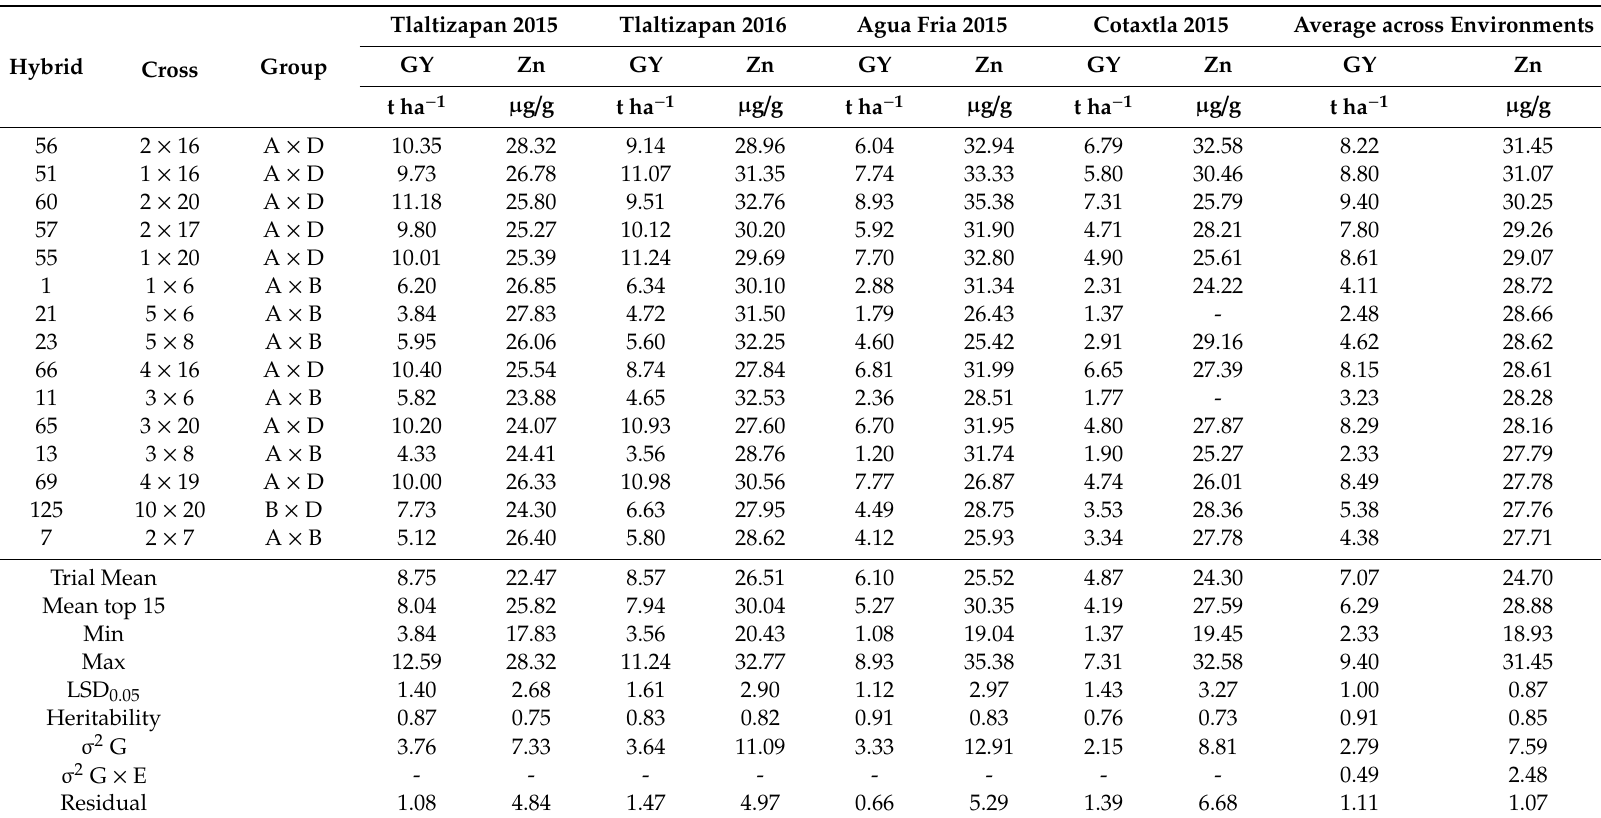
Table 2. Performance of the top ranking 10% hybrids for Zn and their grain yield, averages, heritabilities, and variance components at each environment and across